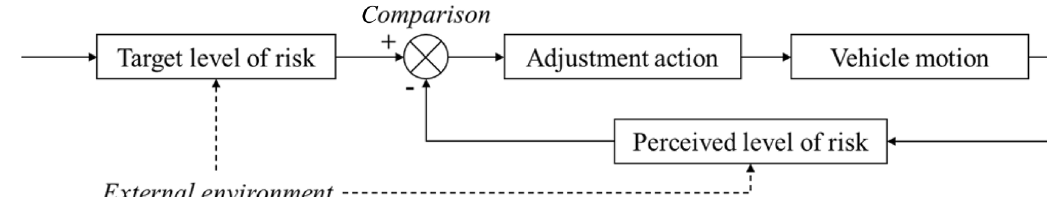
Fig. 1 Risk homeostasis theory